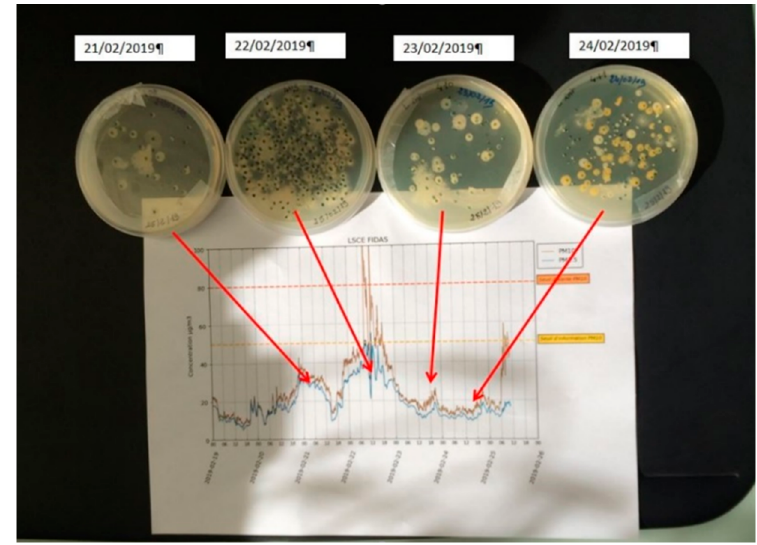
Figure A2. Colors and Shape of different culturable bacteria obtained at Saclay from different air masses.